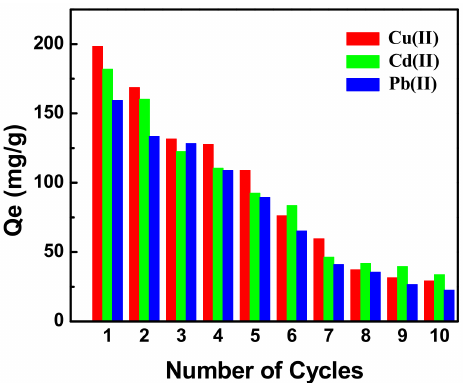
Figure 10. The adsorption capacity of MXCS/PAA on metal ions during regeneration